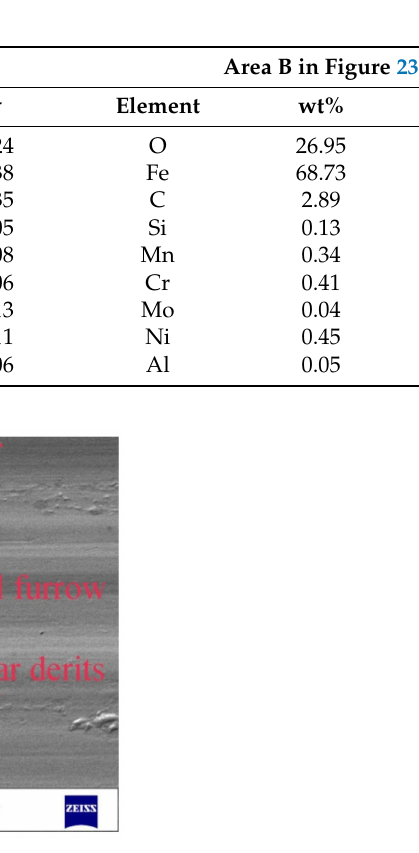
Figure 25. Wear morphology of hardened layer after laser hardening at a scanning speed of 700